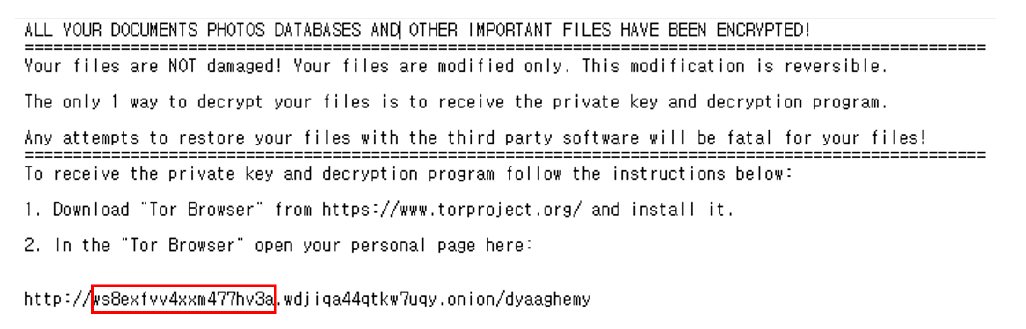
Figure 6. Ransom note of Magniber v2 (the victim’s ID is enclosed in the red-edged